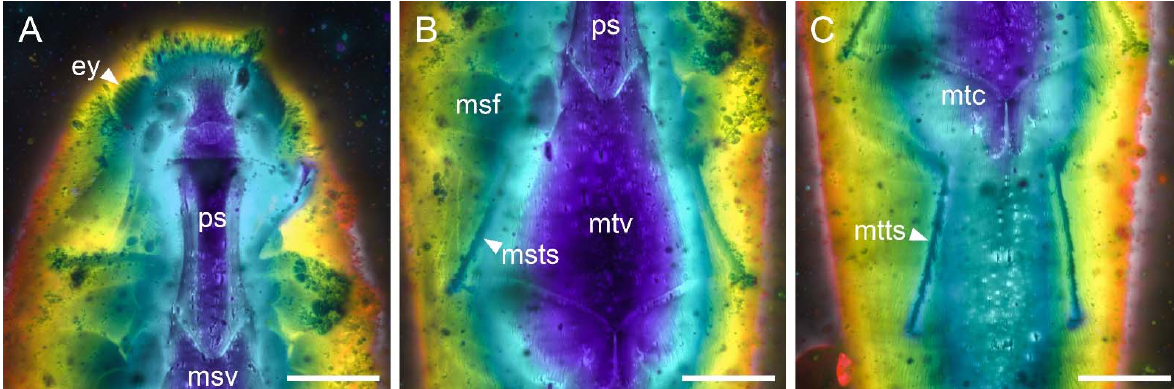
Figure 5. General habitus of Electrothroscus yanpingae gen. et sp. nov. , holotype, NIGP173916, under widefield fluorescence. ( A ) Dorsal view. ( B ) Ventral view. Scale bars: 500 μ m.